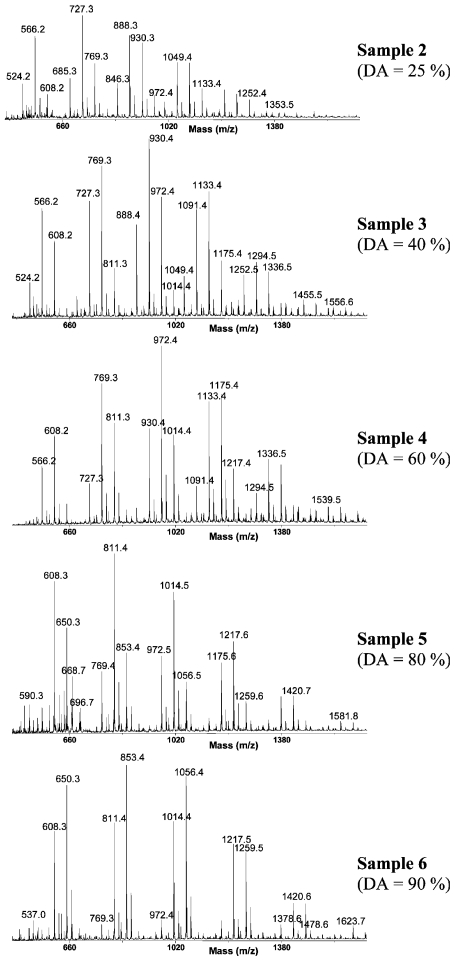
MALDI-TOF MS of chitooligosaccharides with different degrees of acetylation. Reprinted with permission from Biomacromolecules. 2008, 9, 1731–1738. Copyright 2010, American Chemical Society [240].